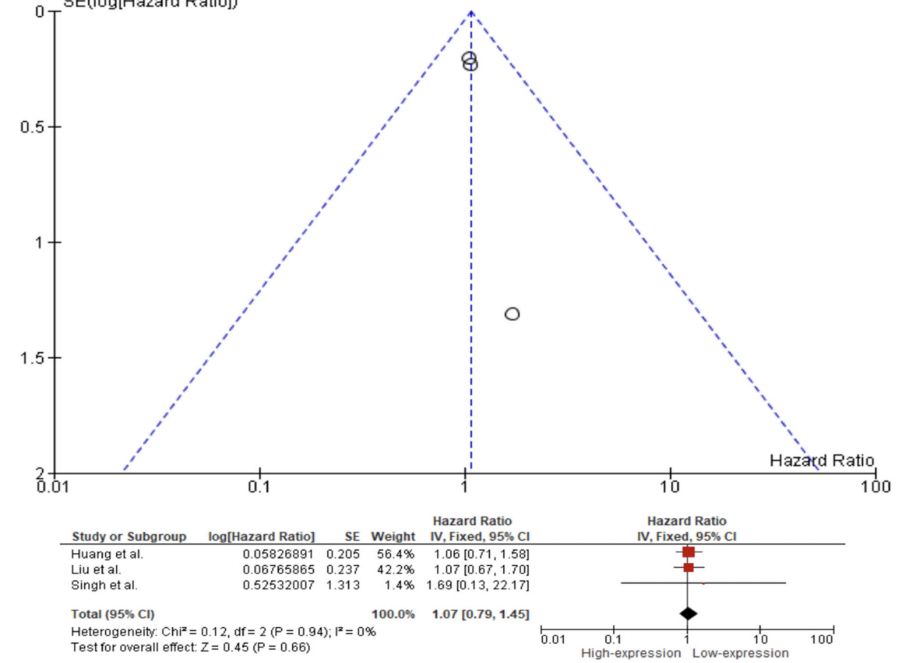
Figure 5. Forest plot and funnel plot for the association of higher Caspase 3 expression with disease- free survival. Squares represent study-specific hazard ratios; horizontal lines represent 95% confidence intervals (CIs); diamonds represent the overall hazard ratio estimate with its 95% CI